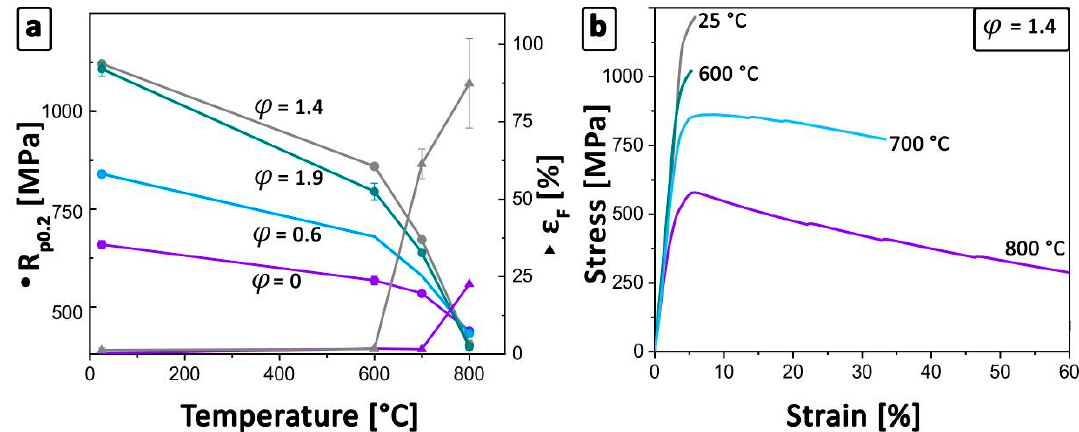
Figure 2. Results of the tensile tests conducted on different material conditions. ( a ) R p0.2 as a function of temperature of the as-HIPed, hot-extruded, and HT material from RT to 800 °C. Test values at 600 °C and 700 °C of the φ = 0.6 series are missing due to a lack of sample material. ( b ) Representative σ – ε curves of the material with φ = 1.4 at temperatures from RT to 800 °C. The results of the tensile and tests for all temperatures and material conditions are summarized in Table 1. The error bars indicate the standard deviation of the respective data point, as shown in Table 1.